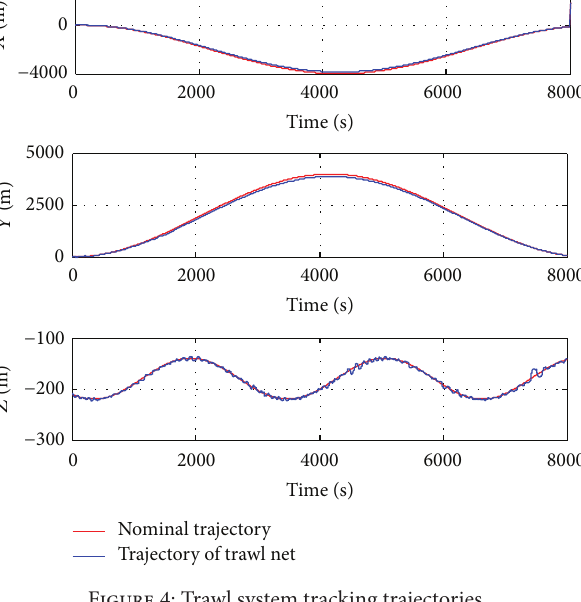
Figure 4: Trawl system tracking trajectories.